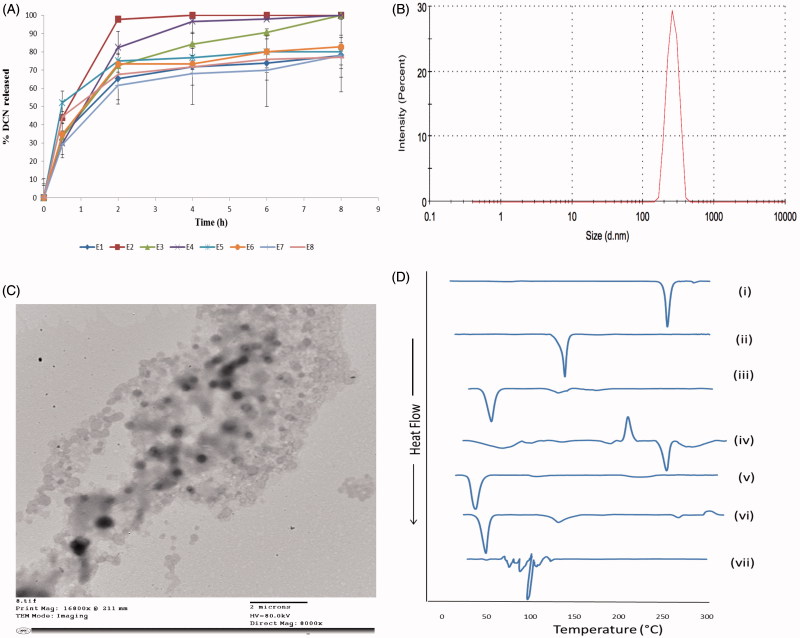
The release profiles of DCN from the prepared eight elastosomal formulations (A). The size distribution curve (B), transmission electron micrograph (C) of E1 and DSC thermograms of (i) DCN, (ii) CH, (iii) Span 60, (iv) STC, (v) Brij S2, (vi) physical mixture of DCN with elastosomal components and (vii) E1 (D).